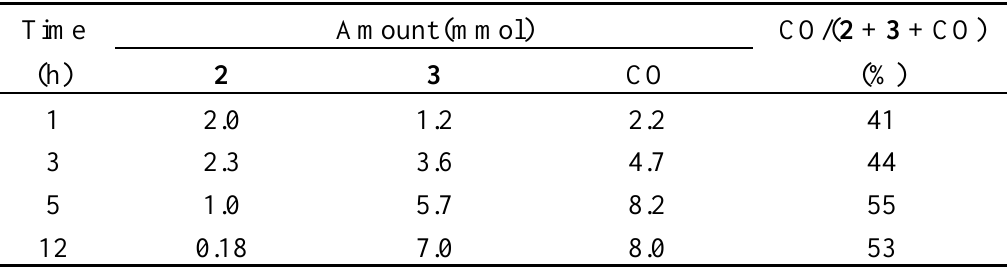
with CO and H using Ru (CO) catalyst a 2 2 3 12